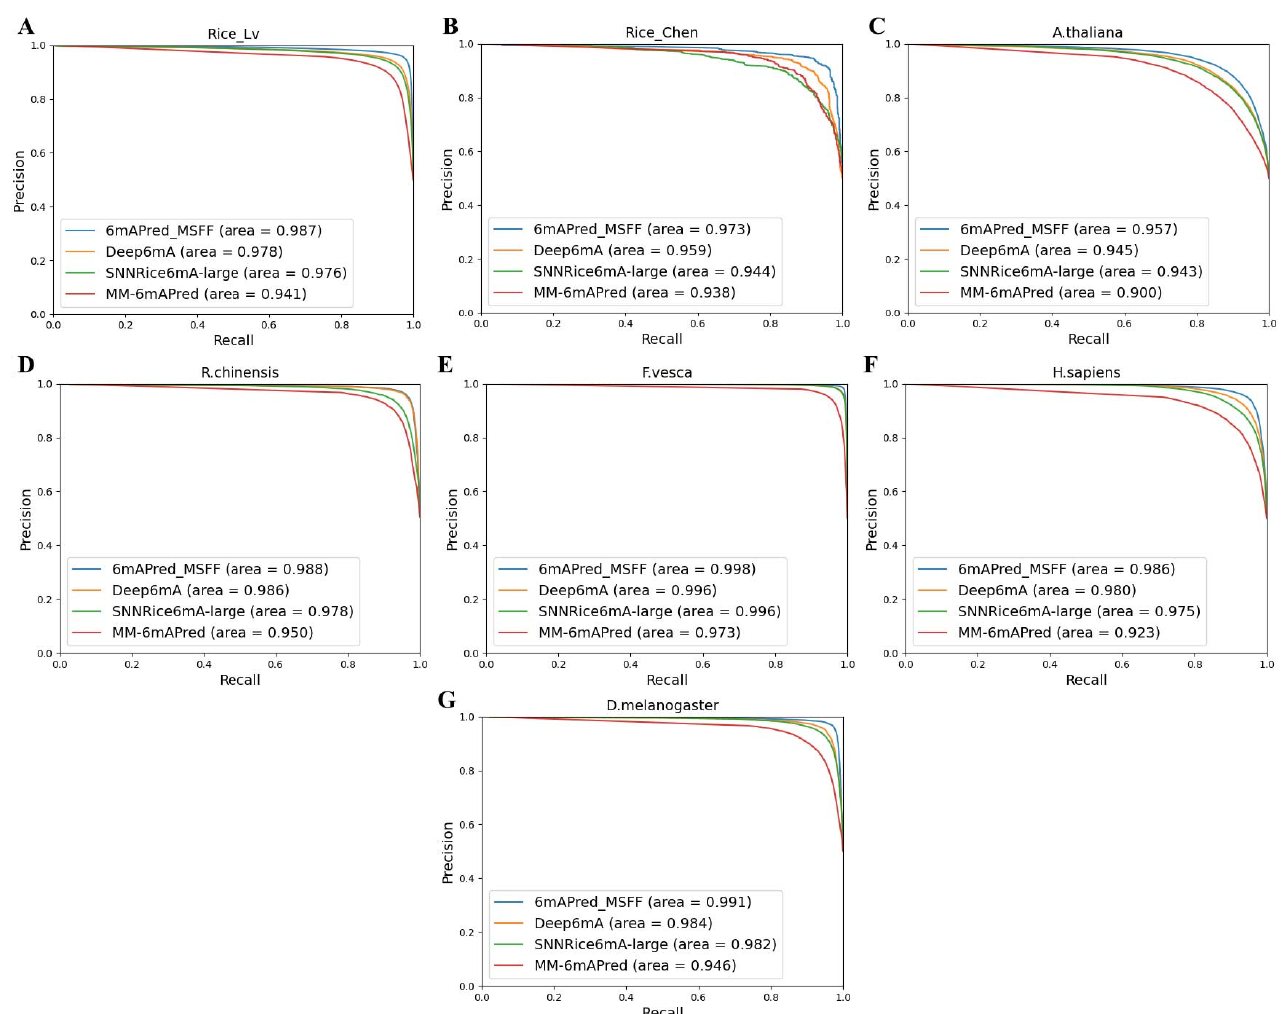
Figure 3. The PRC curves ( A – G ) of four models (6mAPred-MSFF, Deep6mA, SNNRice6mA-large, and MM-6mAPred) based on the seven datasets (6mA-rice-Lv, 6mA-rice-Chen, A. thaliana, R. chinensis, F. vesca, H. sapiens , and D. melanogaster ). Table 3. Performance comparison of methods trained with the 6mA-rice-Lv dataset on cross species. Species Method MCC AUC